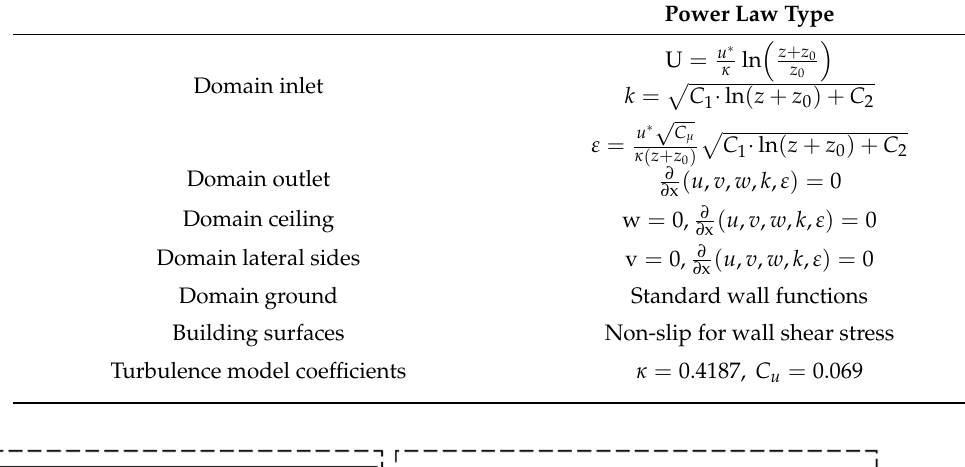
Table 1. Boundary conditions.